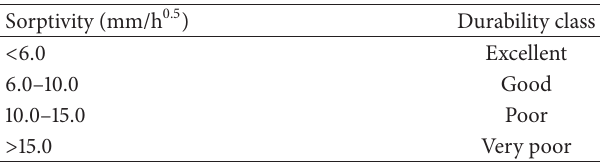
Table 1: Suggested ranges for sorptivity in recycled aggregate concrete.